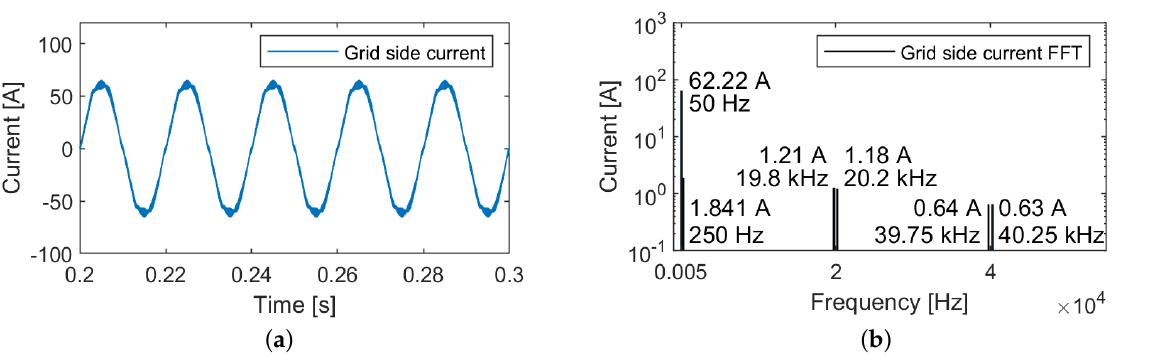
Figure 13. Three-phase three-level neutral point clamped rectifier simulation results. ( a ) Grid side current. ( b ) Grid side current harmonic